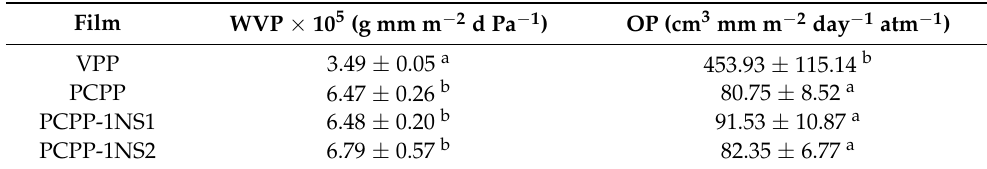
Table 3. Water vapor and oxygen permeability of the